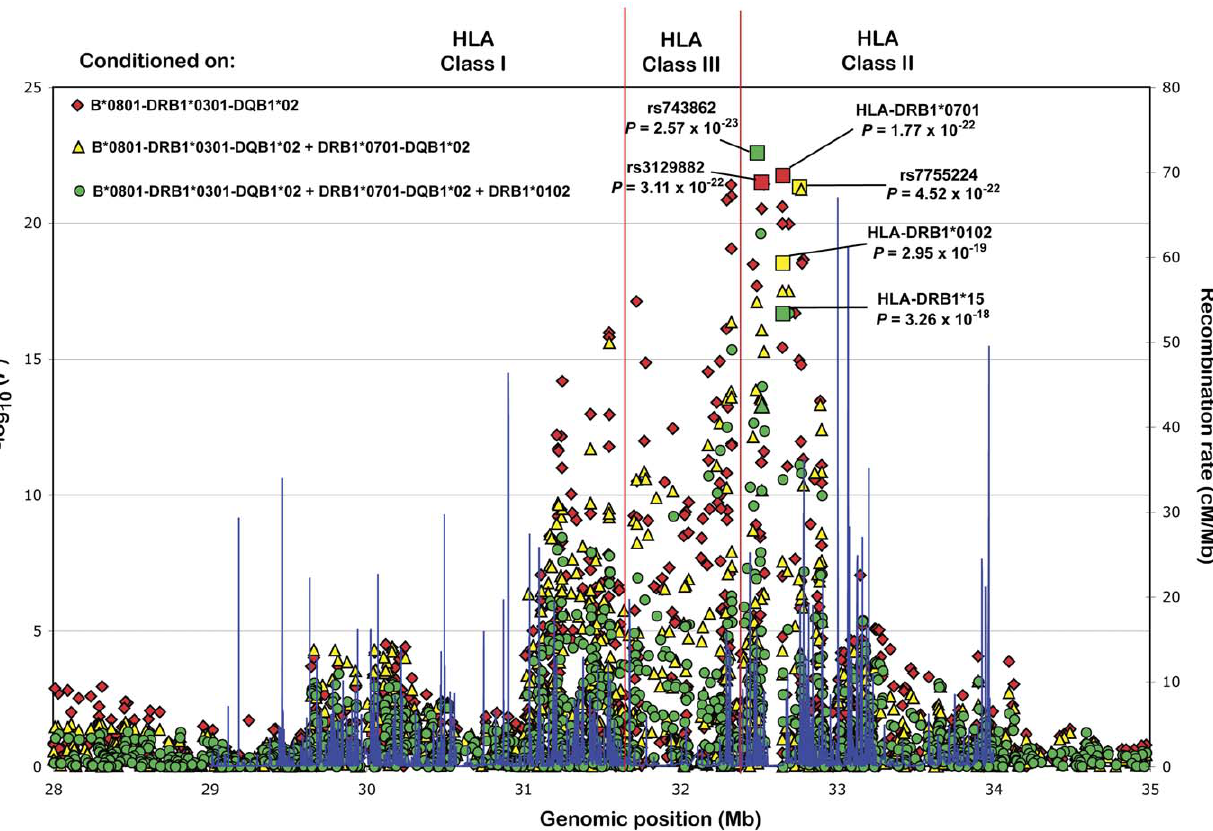
Figure 3. Secondary association signals in the HLA locus. Combined P values are shown for all SNPs and imputed HLA alleles, following conditioning on the HLA-B*0801-DRB1*0301-DQB1*02 (red diamonds), the HLA-B*0801-DRB1*0301-DQB1*02 + HLA-DRB1*0701-DQB1*02 (yellow triangles) and the HLA-B*0801-DRB1*0301-DQB1*02 + HLA-DRB1*0701-DQB1*02 + HLA-DRB1*0102 (green circles) haplotypes. All association results are represented as the 2 log 10 of the combined P values (left y-axis). The most associated SNP and HLA allele in each step of the stepwise conditional logistic regression analysis are indicated by squares. Recombination rates from the HapMap CEU are depicted in blue (right y-axis). Genomic positions on the x-axis are based on the NCBI Build 36 (hg 18) assembly. Mb, megabase